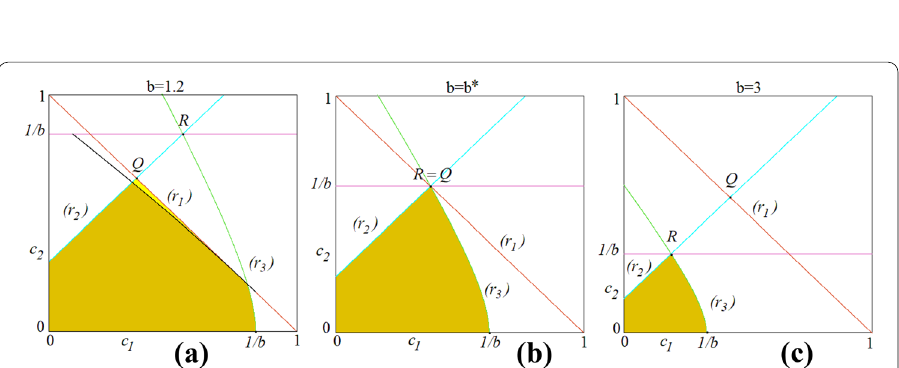
Fig. 3 In color the stability region of the fixed point T ∗ for b > 1 is shown in the parameter plane ( c 1 , c 2 ) . In 1.2 , the black curve denotes the discriminant D a at b = orange region a pair of complex eigenvalues exist. In the yellow region the three eigenvalues are